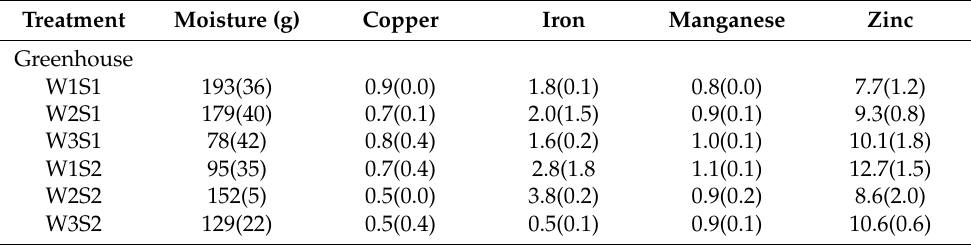
Table 3. Treatment interaction effect of irrigation water regimes, soil types, and environment on micro-nutrients ( µ g g DW) of African horned cucumber